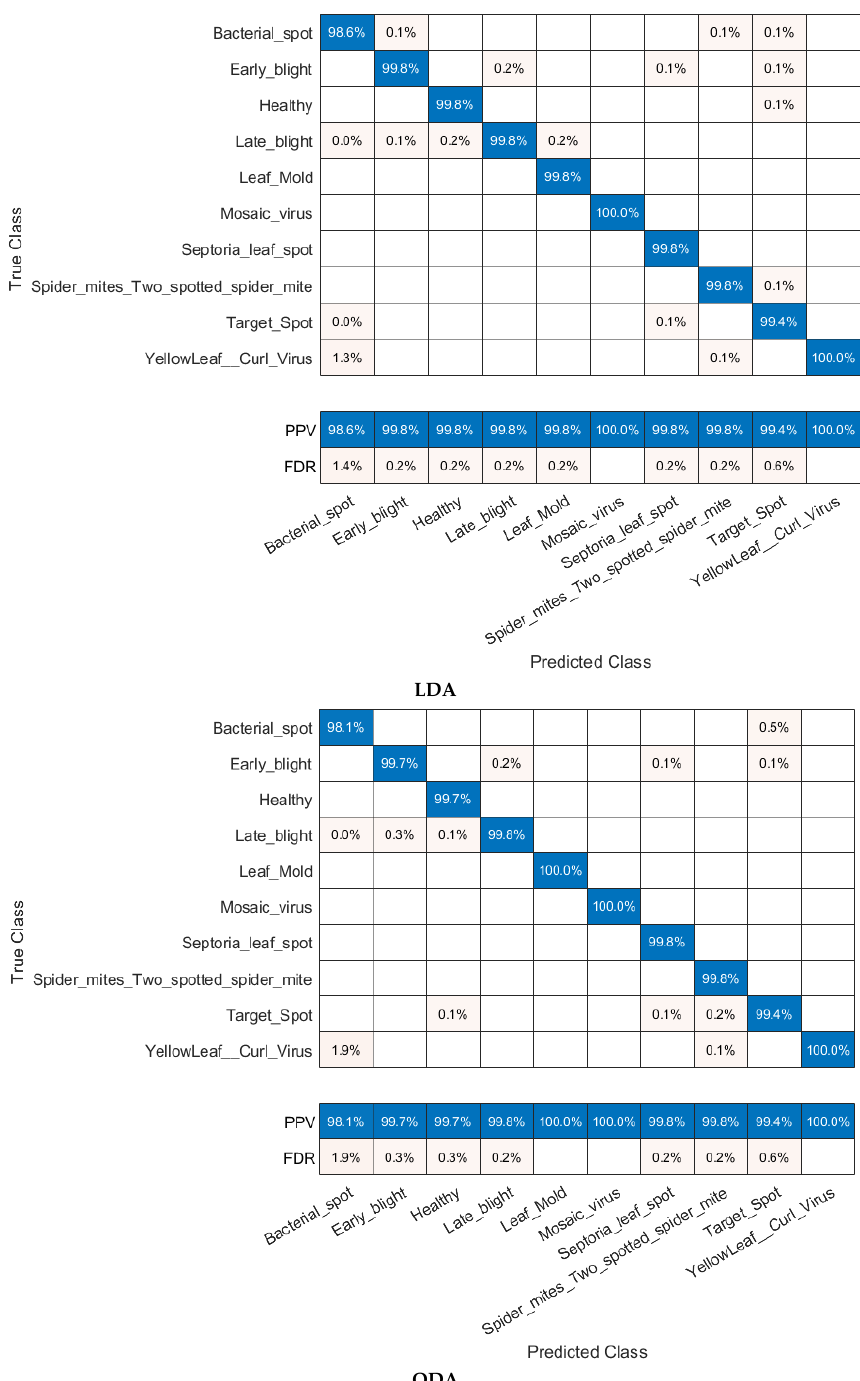
Figure 4. The confusion matrices of the KNN and linear SVM classifiers after feature selection using the bidirectional search methodology.